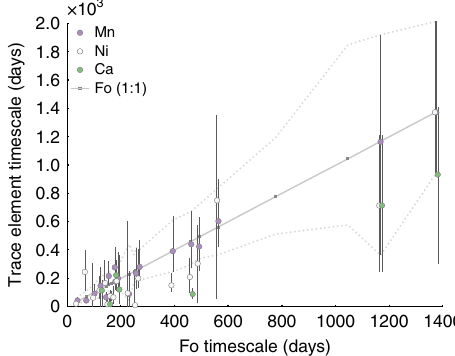
Fig. 3 Timescales results for multiple elements (%Fo, Mn, Ni, and Ca). Note, the %Fo values for the Ni and Ca datapoints are shifted by − 5 and + 5 days, respectively, for visualization purposes. The timescales obtained for %Fo range from a couple of weeks to 4 years. The uncertainty for the % Fo timescales is given with the dotted lines. Timescales obtained from the minor elements (Mn, Ni, and Ca) for the same traverse overlap within error, and suggest that the chemical zoning is mainly controlled by diffusion and not growth 61 . Error bars shown obtained from DIPRA 35 and correspond to the analytical uncertainty and a temperature uncertainty of 30 °C